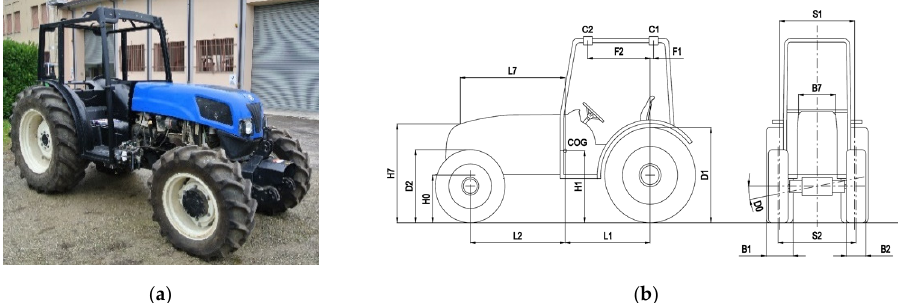
Figure 1. Tested tractor (with non-structural cab components removed) ( a ) and main physical parameters according to Table 1 ( b ).